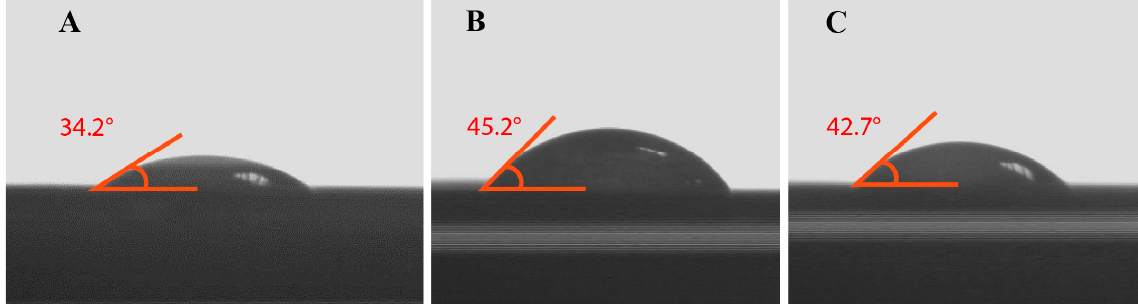
Figure 3. Contact angle images. ( A ) BC-NFs; ( B ) E2-NP/BC-NFs; ( C ) NIP/BC-NFs.